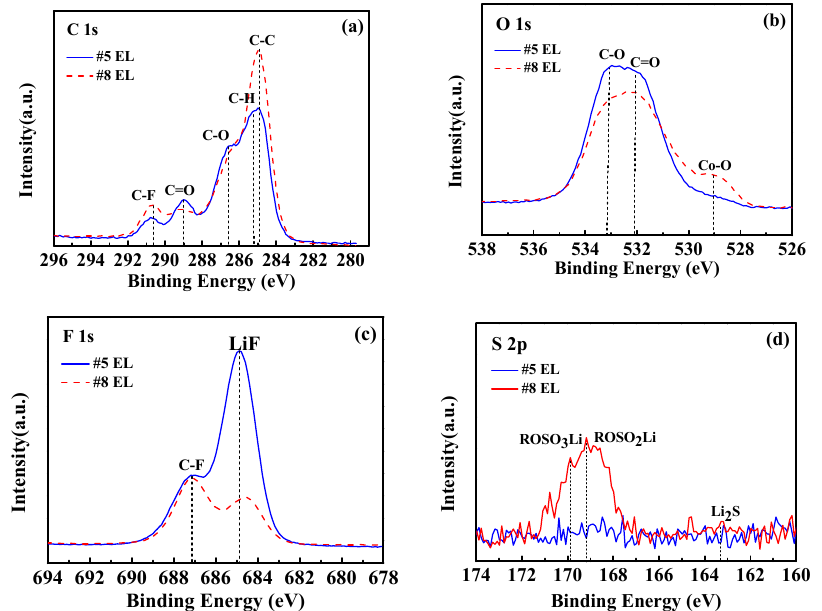
Figure 15. XPS spectra of the LiCoO 2 cathodes cycled in the electrolyte without DDDT additive and in 2 wt.% DDDT after 150 cycles at 45 °C: ( a ) C 1s; ( b ) O 1s; ( c ) F 1s; ( d ) S 2p.